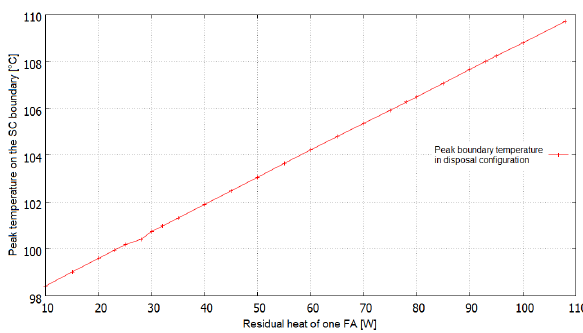
Figure 12. Linear relation between the residual heat generated by the SNF and peak SC/bentonite inter- face temperature in the disposal configuration. The limiting temperature corresponds to the 23 Watts per one WWER-440 SNF assembly in homogeneous con- figuration of the SC CASTOR